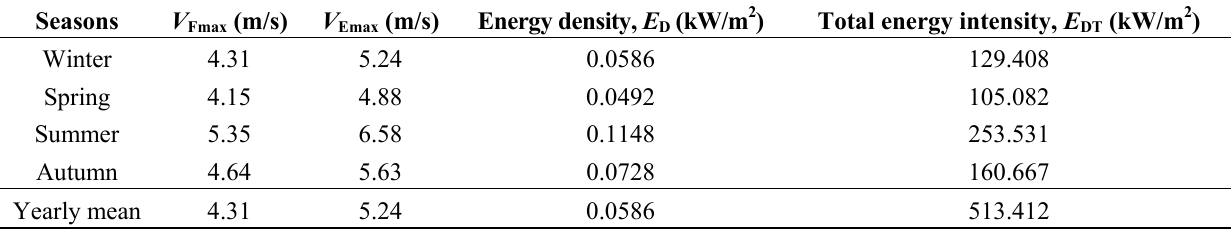
Table 15. The most frequent wind velocity ( V energy ( V ), energy density ( E Emax